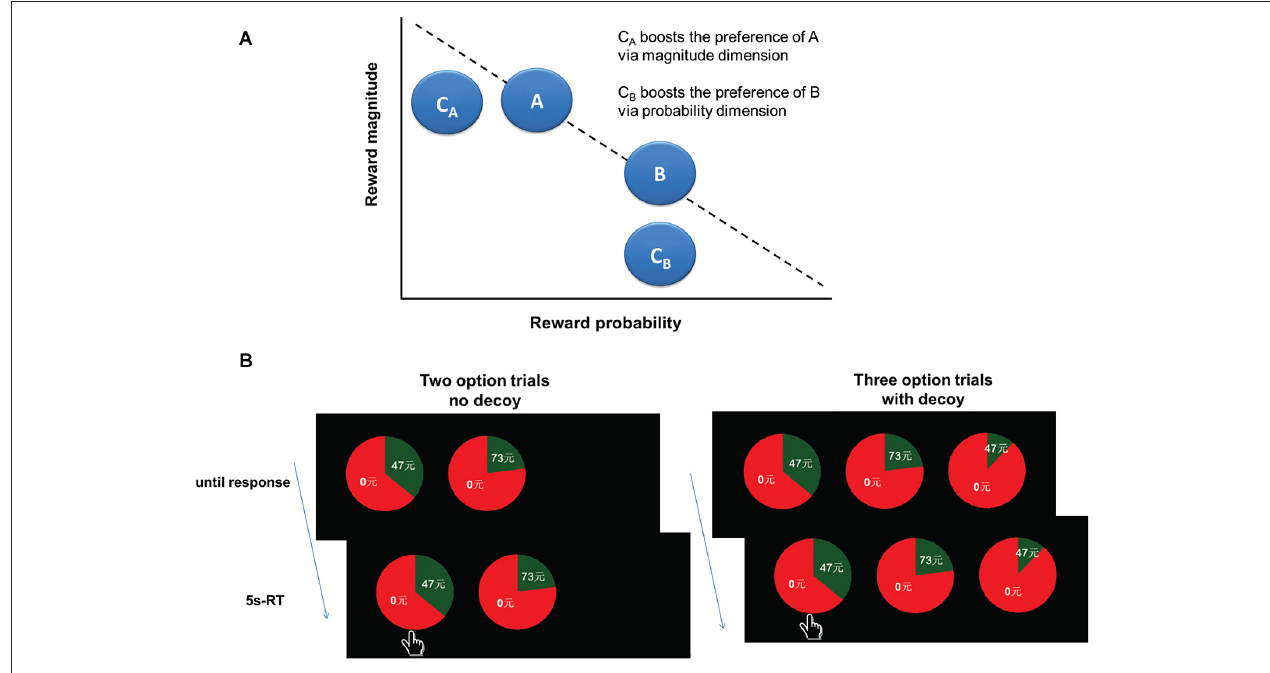
same amount of money or the same probability but with a smaller probability or amount of money than one of the two original gamble options, making this original gamble option the target, and the other original gamble option the competitor. The only difference between the three-option and the two-option conditions was whether the decoy option was presented or not. The two gamble options in the two-option condition were randomly presented in two of three positions. The gamble options were presented for 5 s, during which participants were instructed to make a choice by pressing 1, 2 or 3 on the keypad. Participants were also told that during the task they would not receive feedback concerning the outcomes of their